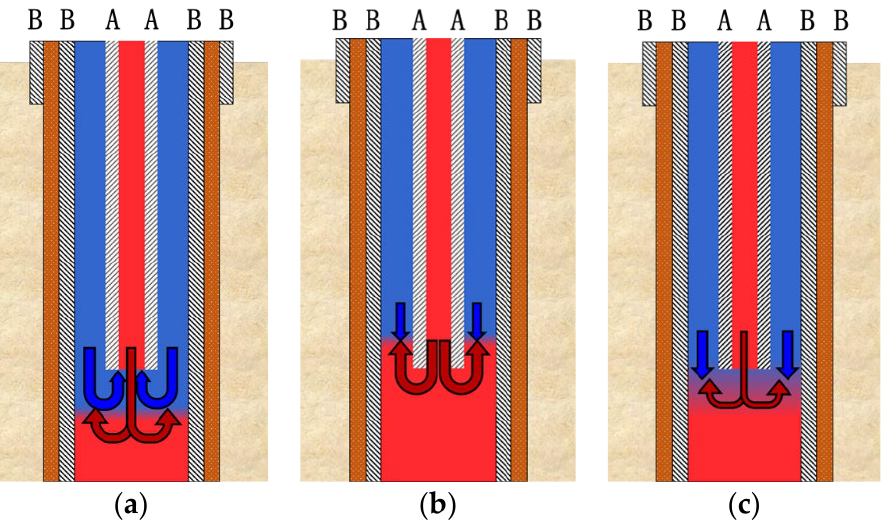
Figure 1. Mixing modes of nitrogen and steam under different nitrogen injection rates. Note: A represents the heat insulation oil pipe, B represents the sleeve, and the red area between A-A represents the injection of steam into the heat insulation pipe. The blue area in A-B indicates that nitrogen is injected into the oil jacket annulus. B-B indicates the cement sheath between the first and second split casings. ( a ) the nitrogen injection displacement is too large; ( b ) the nitrogen injection displacement is too small; ( c ) the nitrogen injection displacement is reasonable. Among the three injection conditions, Figure 1c shows the critical injection amount of nitrogen insulation. Under this working conditions, the dryness of the injected steam is improved, and the casing is kept in a low temperature environment, which effectively improves the heat insulation effect of the injected string annulus. In this situation, in order to ensure that the interface is located at the outlet of the heat insulation pipe stably, theoretically, the position of the interface can be relatively stable only when the momentum of nitrogen in the casing annulus and the momentum of steam returning from the annulus are in equal motion. The critical nitrogen injection displacement model of the annulus is related to the pressure at the outlet of the insulation pipe, the temperature of casing annulus, dryness of steam, the mass flow rate of steam, and other factors. Therefore, it is necessary to establish the steam parameter prediction model in the heat insulation pipe and the nitrogen parameter prediction model in the casing annulus respectively, then build the momentum balance model of nitrogen and steam at the outlet of the heat insulation